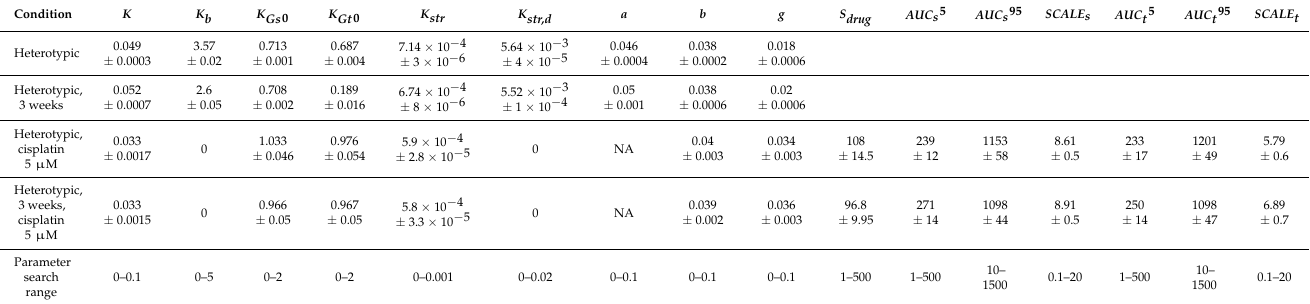
Table 1. Model parameters and parameter search ranges for PSMSR, including the 95% confidence